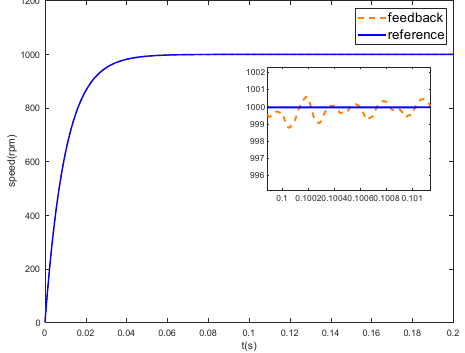
Figure 12. Speed response curve when α = 0.002.